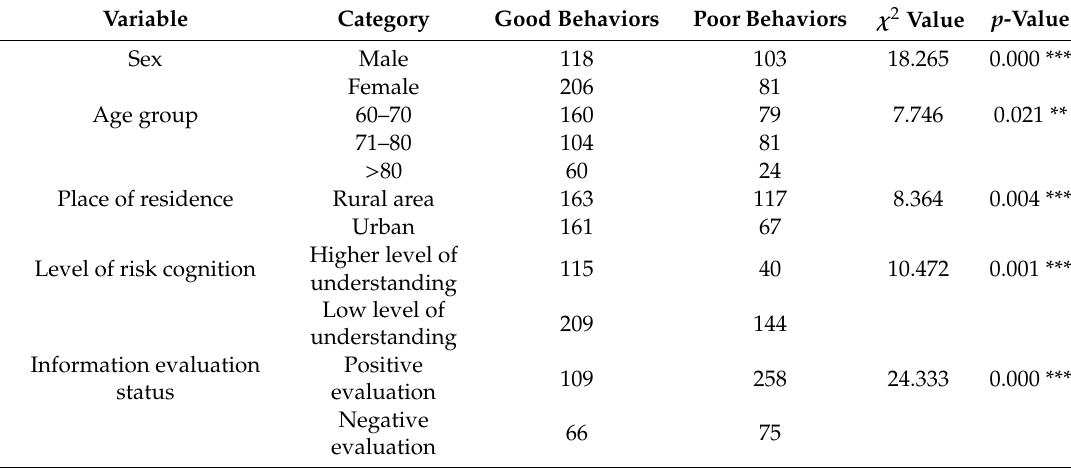
Table8. Chi-squaretestforprotectivebehaviorsagainstCOVID-19basedondifferentpopulationcharacteristics.